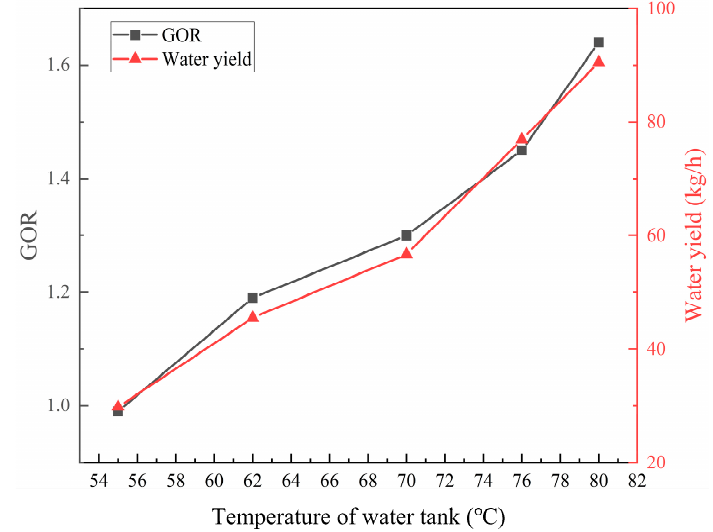
Figure 20. Freshwater output at different temperatures of the water tank.